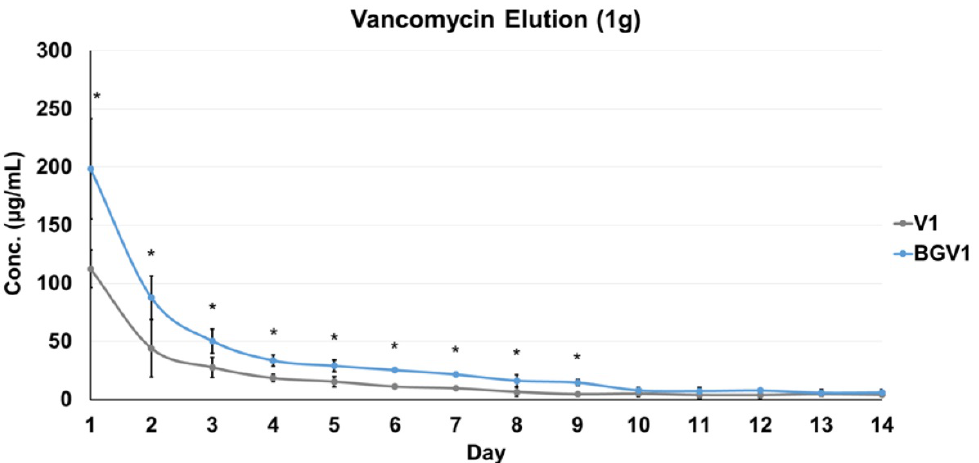
Figure 1. Vancomycin concentration of daily eluate for 1g groups (n=10). An asterisk (*) above a data point indicates a significant difference (p<0.05) between BGV1 and V1. Error bars indicate ± one standard deviation from the